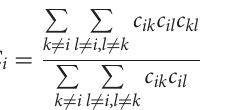
proportion of the number of connections and the maximum number of connections between a node and adjacent nodes.